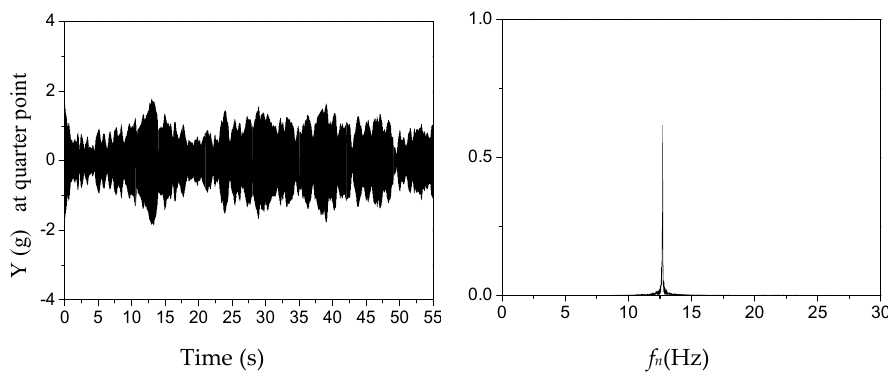
Figure 6. Crosswind oscillation details (U = 8.3m/s, U/ f 0 D = 7.9) at the quarter point of the 3D prototype prism.